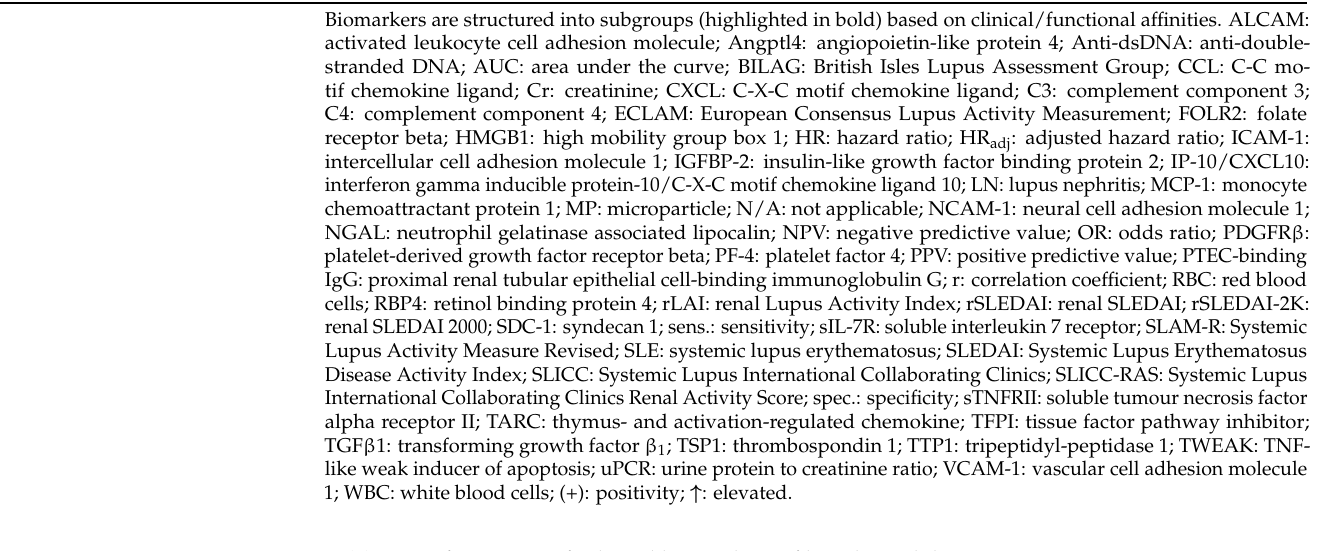
Table 3. Performances of selected biomarkers of histological disease